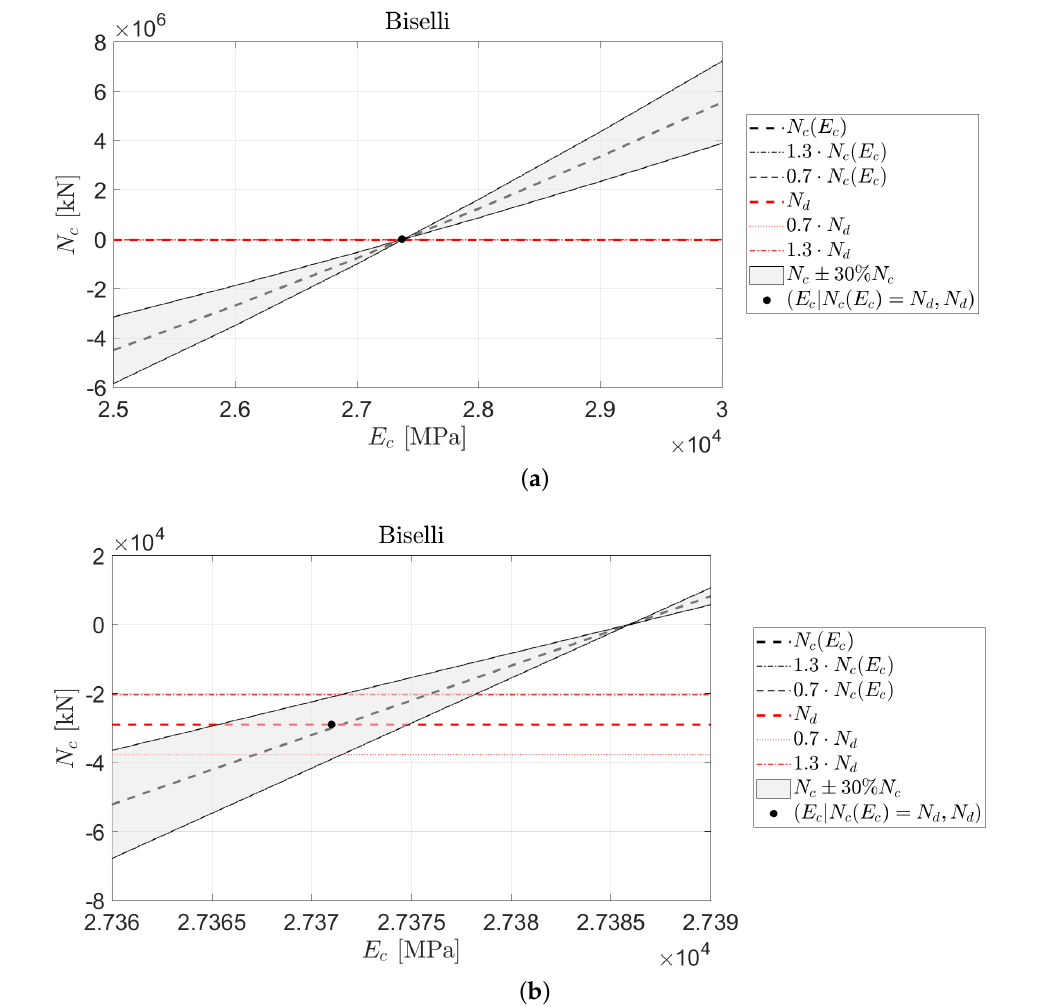
Figure 5. Estimated values of the elastic modulus to yield the design prestressing value within the given ± 30% confidence bounds: ( a ) spans between 25,000 and 30,000 MPa, ( b ) focuses on the estimated